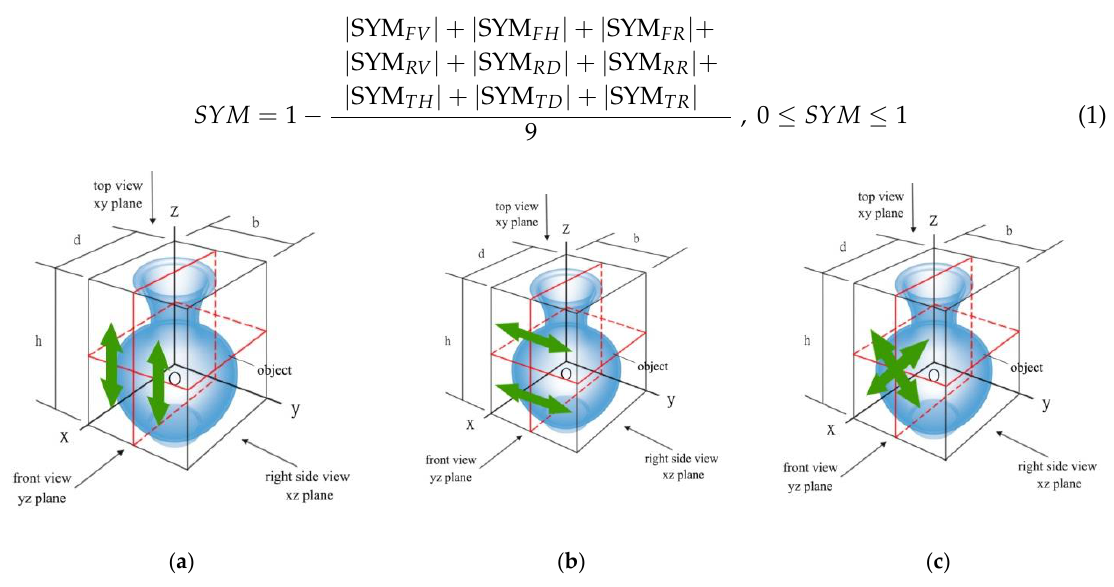
Figure 1. Symmetry of an object in ( a ) vertical, ( b ) horizontal, and ( c ) diagonal directions. Among which |SYM| is the overall symmetry, |SYM 𝐹𝑉 | is the horizontal symmetry of front- view direction; |SYM 𝐹𝐻 | is the vertical symmetry of front-view direction; |SYM 𝐹𝑅 | is the diagonal symmetry of front-view direction. |SYM 𝑅𝑉 | is the vertical symmetry of right-view direction; |SYM 𝑅𝐷 | is the horizontal symmetry of right-view direction; |SYM 𝑅𝑅 | is the diagonal symmetry of right-view. |SYM 𝑇𝐻 | is the horizontal symmetry of top-view; |SYM 𝑇𝐷 | is the vertical symmetry of top-view; |SYM 𝑇𝑅 | is the diagonal symmetry of top-view. When the obtained SYM value approaches 1, the form has a higher level of